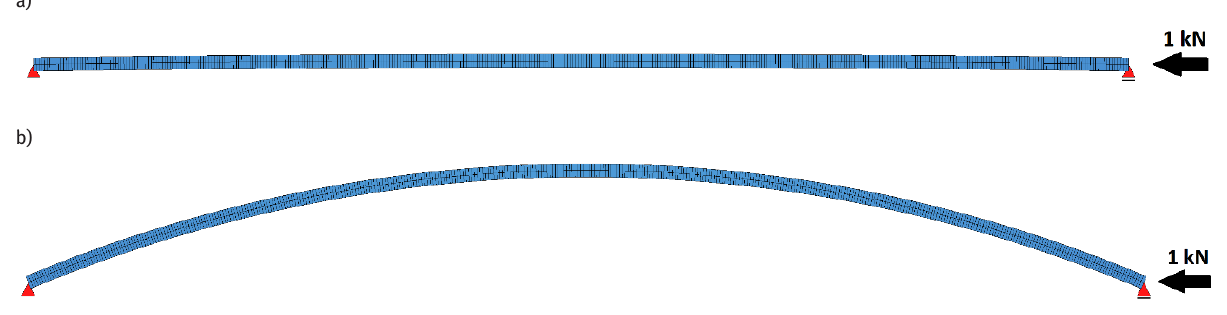
Figure 6: Sample geometry of columns with the lowest (a) and highest (b) elevation with initial loads.